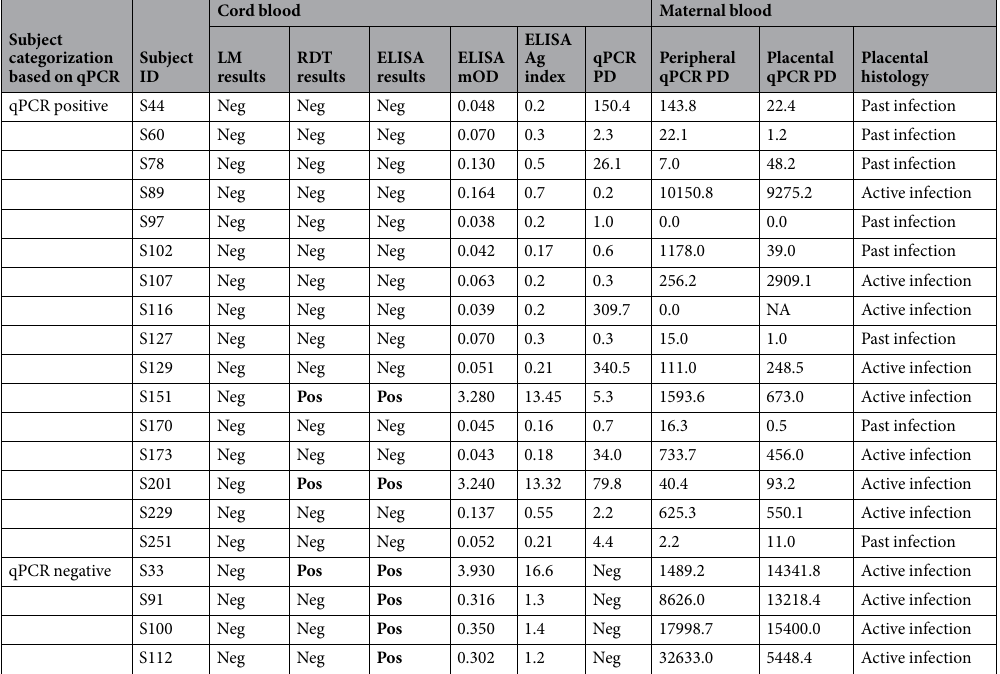
Table 3. Row data showing positive cord blood samples as detected by qPCR, RDT and/or ELISA (n = 20). The data includes the mean optical density and the derived antigen index by ELISA, placental histology results and, parasite densities in cord, maternal peripheral and placental blood. qPCR, quantitative real-time Polymerase Chain Reaction; LM, Light Microscopy; RDT, rapid diagnostic test; ELISA, Enzyme-Linked ImmunoSorbent Assay; mOD, mean optical density; Ag index, Antigen index obtained by dividing the mOD of each sample by the cut-off value; PD, parasite density (number of parasites/ µ L) as calculated by qPCR; ID, identification; NA, Not available; Pos, positive (in bold); Neg,